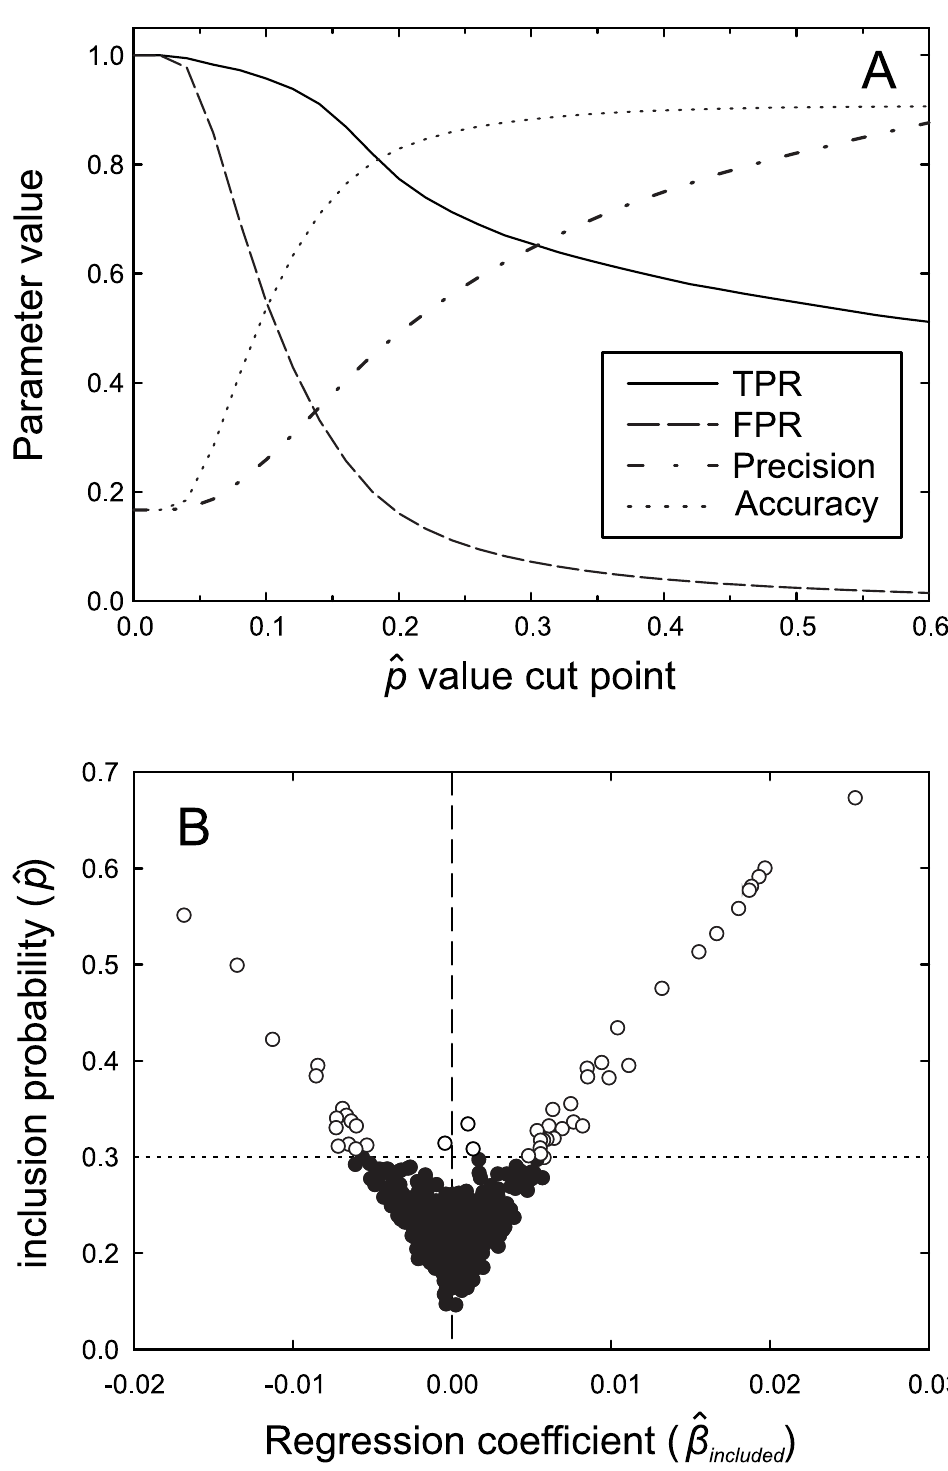
Fig 3. Cut point estimation. Fig 3A: Method performance measures are plotted as a function of the ^ p ^ cut point value. Data is from 1000 microbiome datasets simulated for a community of N = 20 contributing bacteria and N = 100 non- contributors. Fig 3B: Plot of the inclusion probability ( ^ p ^ ) as a function of the regression coefficient ( ^ b ^ from a BRACoD analysis of rats fed diets differing in dietary fiber. Visual inspection of the distribution of ^ b ^